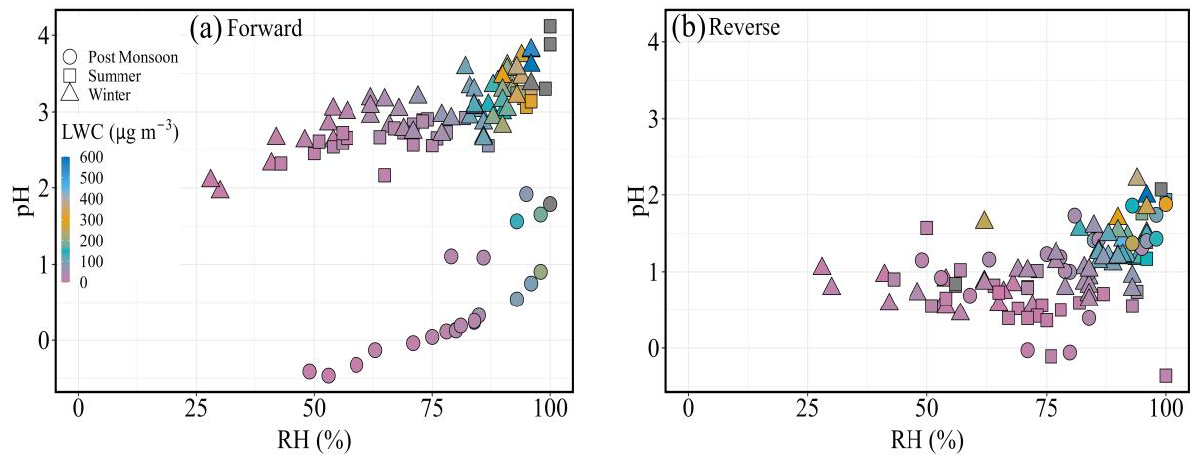
Figure 4. Relationship between aerosol pH and relative humidity at varying LWC in ( a ) forward and ( b ) reverse mode.